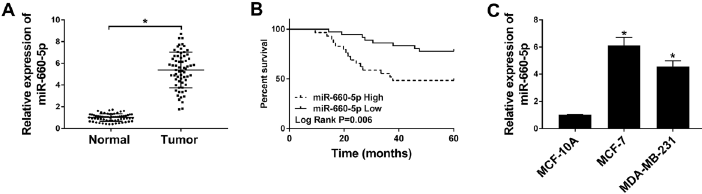
Figure 1. A , The level of miR-660-5p was measured in breast cancer (BC) tissues (n=65) and corresponding normal tissues (n=65) by qRT-PCR. B , The survival rate was analyzed in miR-660-5p high and low expression BC patients using Kaplan-Meier analysis and log- rank test. C , The abundance of miR-660-5p was detected in normal human breast epithelial cell MCF-10A (n=3) and BC cells (n=3) by qRT-PCR. Data are reported as means ± SD. *P o 0.05 (ANOVA).